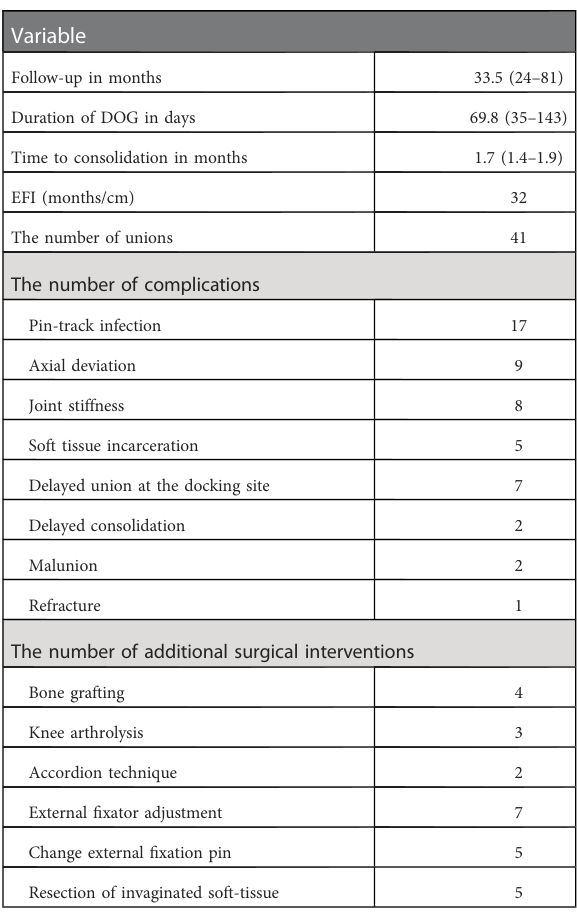
TABLE 4 Details of the outcomes and